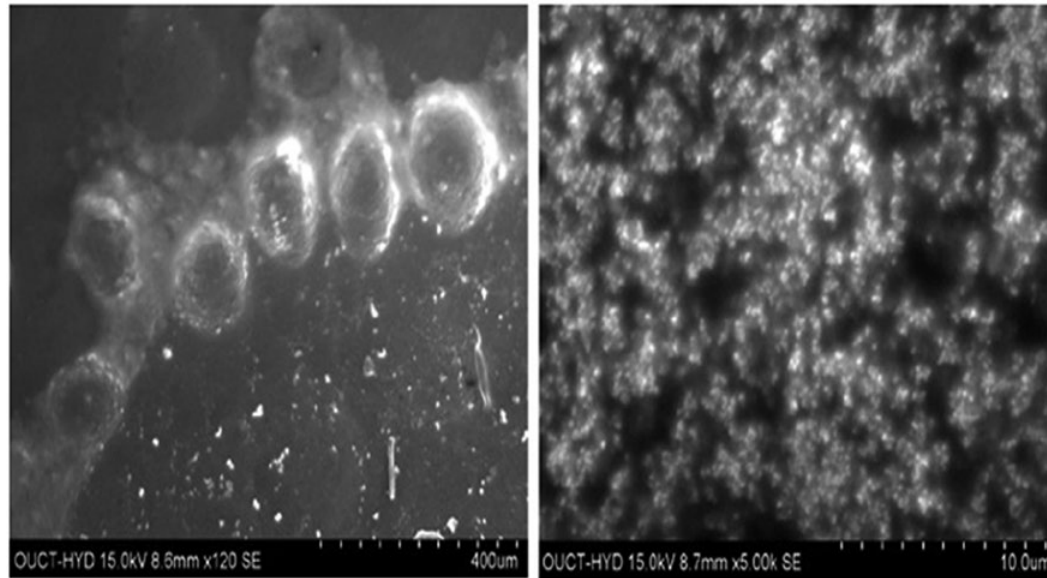
FIGURE 2 - SEM images of TDF-ACNs prepared with PLGA RG503H of formulation F3.